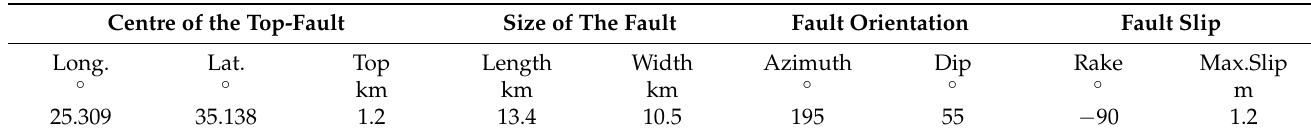
Table 3. Parameters of the modelled fault based on the combined inversion of both InSAR and GNSS data.